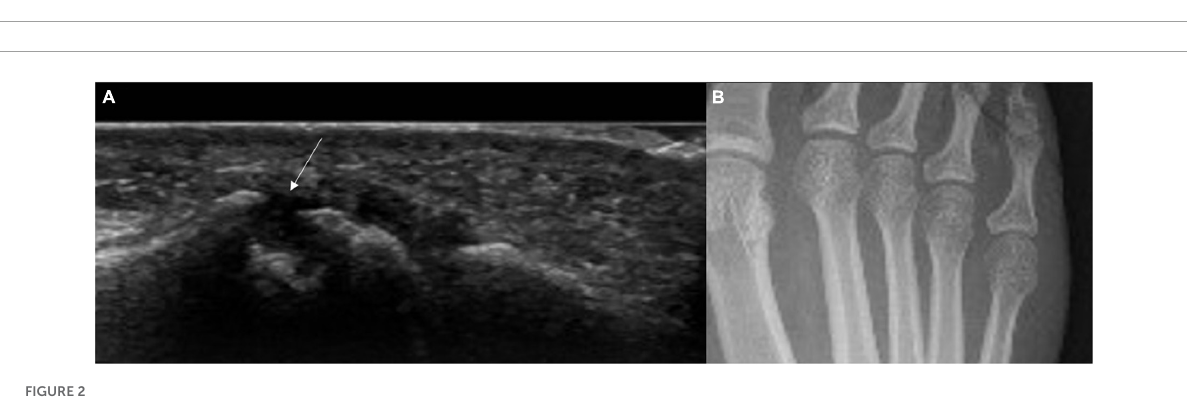
FIGURE1 US sub-clinical synovitis and tenosynovitis in ACPA+ individuals with MSK symptoms. Gray scale (A) and power Doppler (A’) positive synovitis of the 3rd MCP joint in a patient at-risk of RA high titre positive anti-CCP antibodies and non-specific musculoskeletal symptoms. Similar US findings are shown in the 2nd PIP joint in a different at-risk individual (B,B’) with positive anti-CCP antibodies and rheumatoid factor, hands arthralgia. (C,C’) Illustrate tenosynovitis of the 2nd extensor tendon compartment in a third individual at-risk of RA with high titre anti-CCP antibodies and clinically suspect arthralgia. All images were obtained using a longitudinal approach. Asterisks indicate synovial hypertrophy.